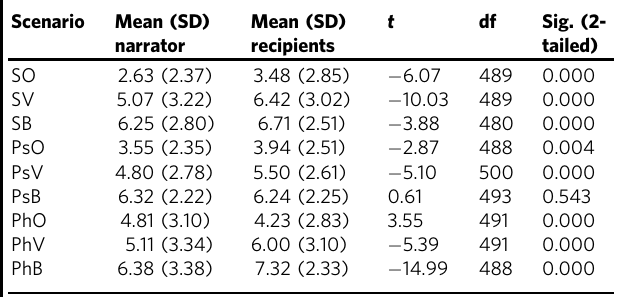
Table 2 Severity ratings of violence for narrators and recipients.